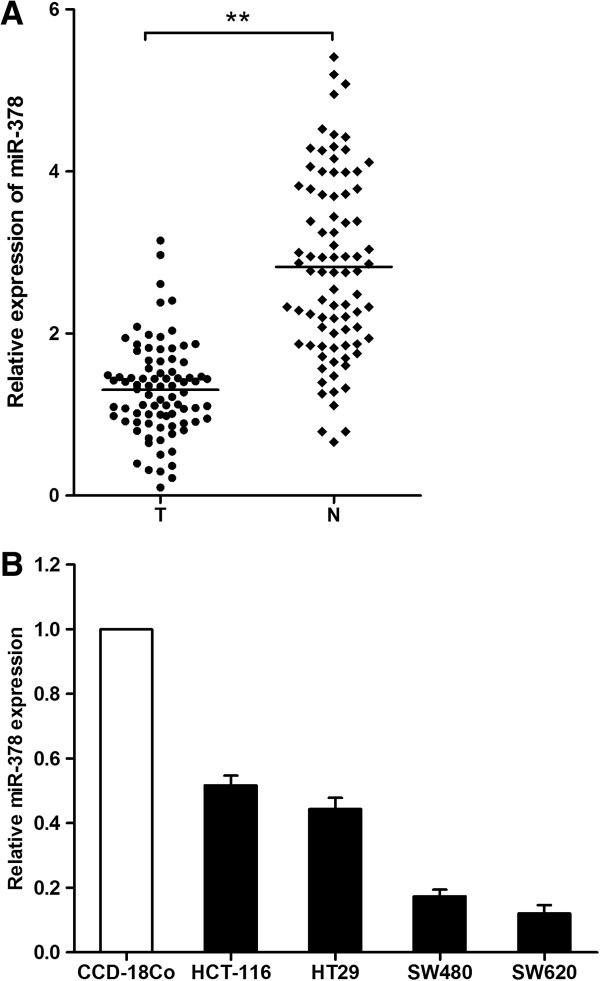
The relative expression levels of miR-378 in CRC tissues and cell lines. (A) The relative expression of miR-378 in CRC tissues (T) and adjacent normal mucosa (N). The bars in the figure indicate the means of the relative expressions of miR-378. (B) The relative expression of miR-378 in CRC cell lines SW620, SW480, HCT116, HT29 and the normal colon epithelium cell line CCD-18Co. **P < 0.01.